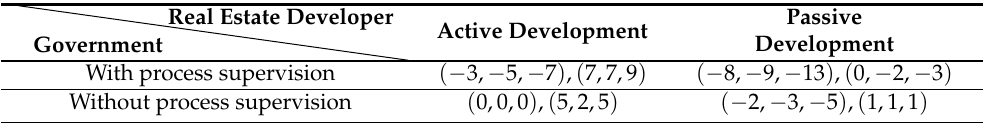
Table 3. Triangular fuzzy profit and loss value matrix of pure strategy game between government and real estate